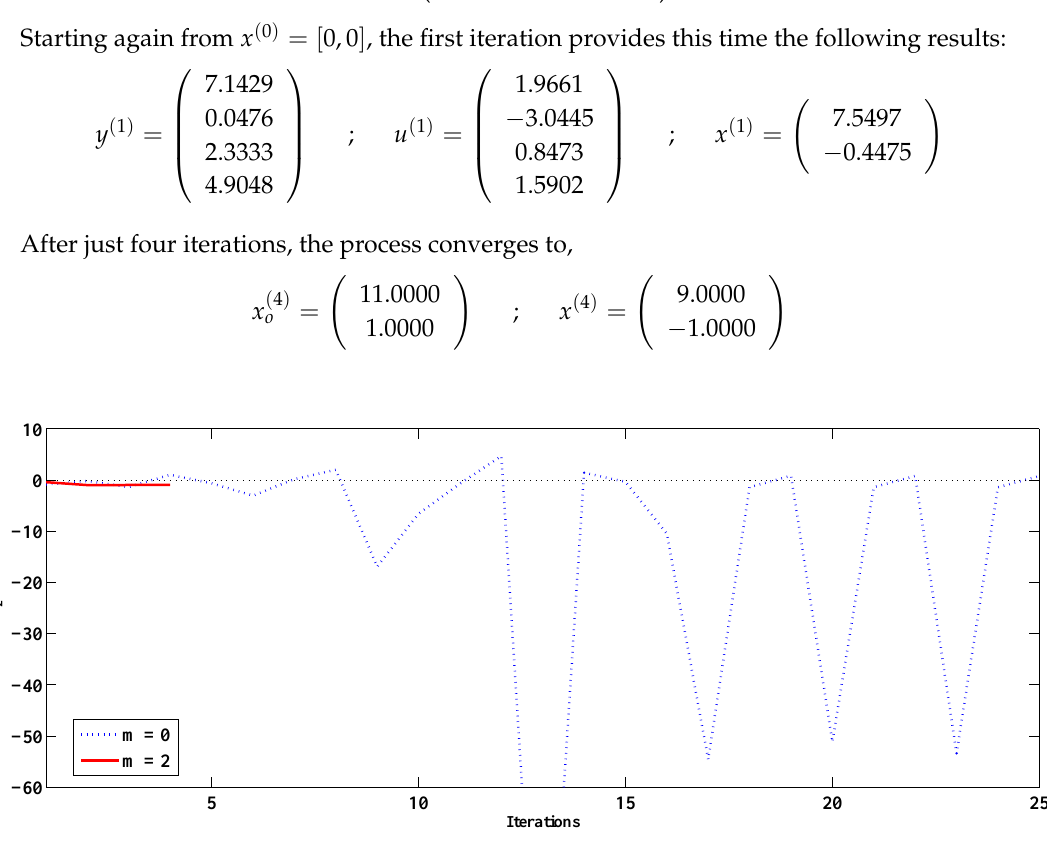
Figure 1. Evolution of x 2 as iterations progress for the simple system of Examples 1 ( m = 0) and 2 ( m =